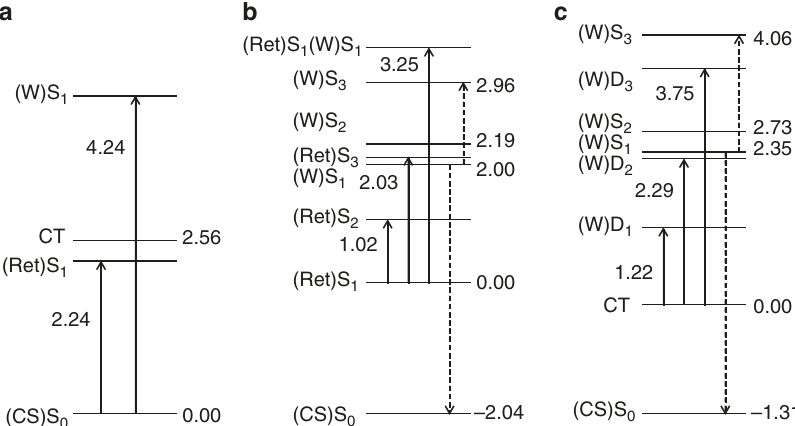
Fig. 4 Computed energies characterizing electronic coupling between retinal and Trp86. Solid arrows indicate retinal and Trp86 absorption; dashed arrows indicate absorption and emission of excited Trp86 populated by a sequential two-photon process. All computed energies and transition dipole moments (tdm) are presented in Supplementary Tables 2 and 3, respectively. a Transitions of the retinal and Trp86 corresponding to the light-adapted state of bacteriorhodopsin. b Transitions from the relaxed retinal S 1 state. Absorption of a second photon may populate the retinal S 3 state at 2.03 eV (tdm = 5.37 au) coupled to the excited Trp86 (W)S 1 state at 2.0 eV (tdm = 0.15 au). c Transitions from the relaxed CT state. Photon absorption populates the excited Trp86 radical state (W)D 2 at 2.29 eV (tdm = 1.00 au) coupled to the excited Trp86 (W)S 1 state at 2.35 eV (tdm = 0.45 section. Instead, we developed a protocol for on-line pre-illumi- all- trans and from 35% to 20% 13- cis retinal, respectively, com- nation of the microcrystalline bR stream as it fl owed through our pared to 45% all- trans and 55% 13- cis retinal in the dark- high viscosity extrusion (HVE) injector 26 . A fully de fi ned “ dark adapted state. zone ” near the HVE exit allowed the crystals to return to the bR ground state prior to being photoexcited with the optical pump laser pulse. Pre-illumination increased the all- trans retinal con- tent considerably, with compositions ranging from 65% to 80%